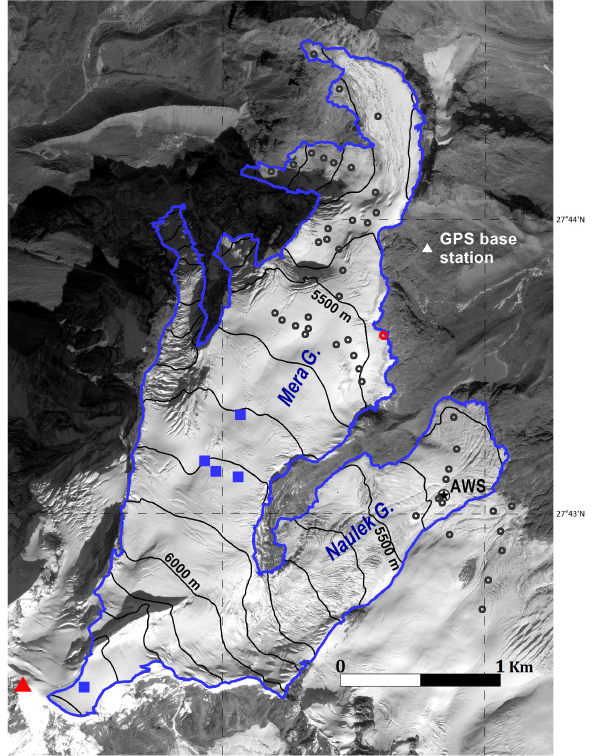
Fig. 2. Map of Mera Glacier, showing the network of ablation stakes (grey circles and one peculiar stake highlighted in red, see text for details), the accumulation measurement sites (blue squares) and the Mera automatic weather station (AWS – black star). From the Mera central summit (red triangle), Mera Glacier flows toward the north and splits into two main branches, referred as Mera and Naulek branches respectively. Background: Pleiades-1A image of 25 November 2012 (CNES 2012/Distribution Astrium).